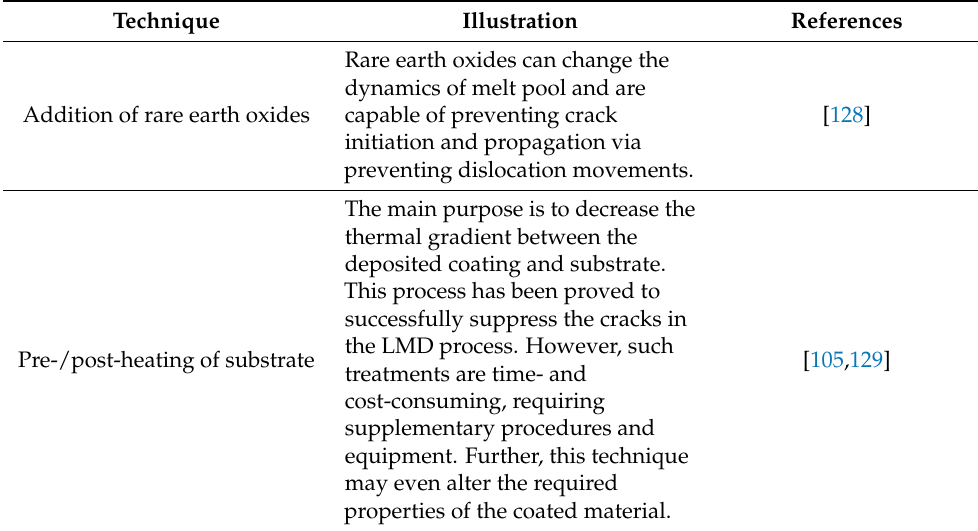
Table 7. Different techniques to optimize the bonding between substrate and